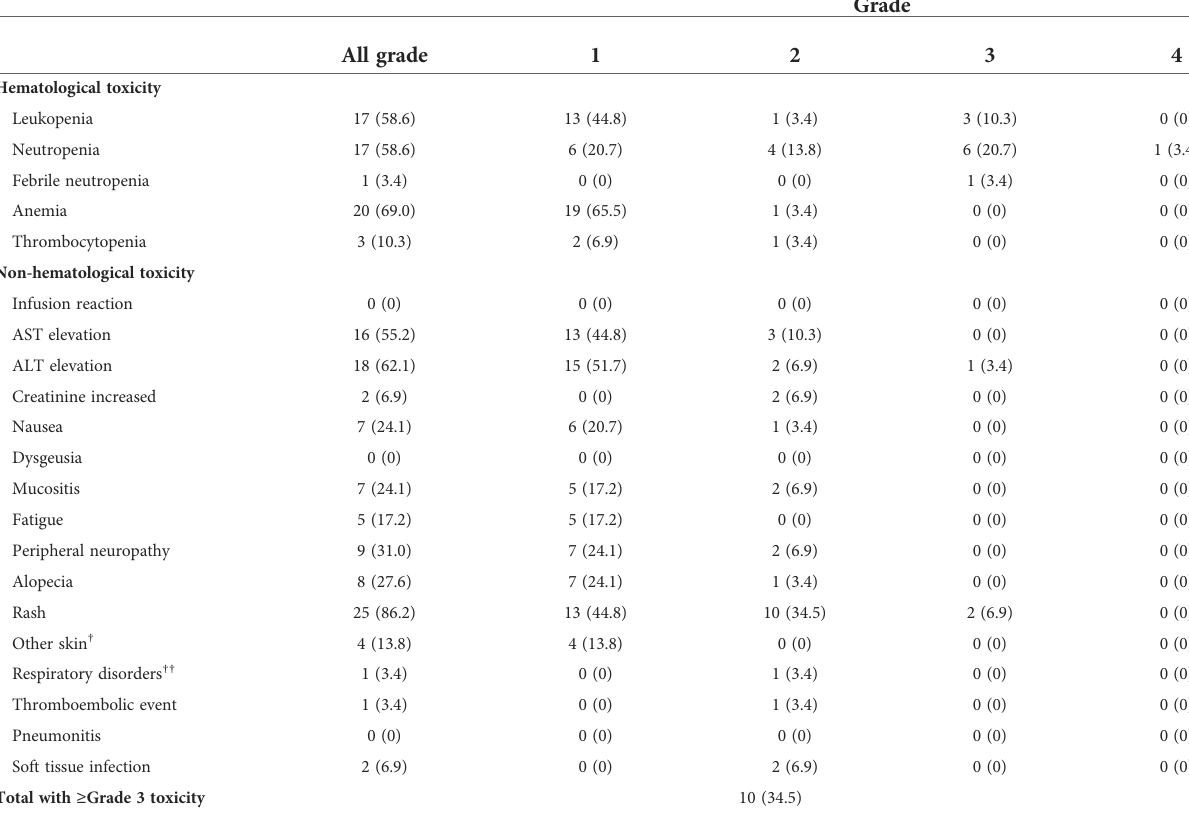
TABLE 3 Selected toxicity during induction